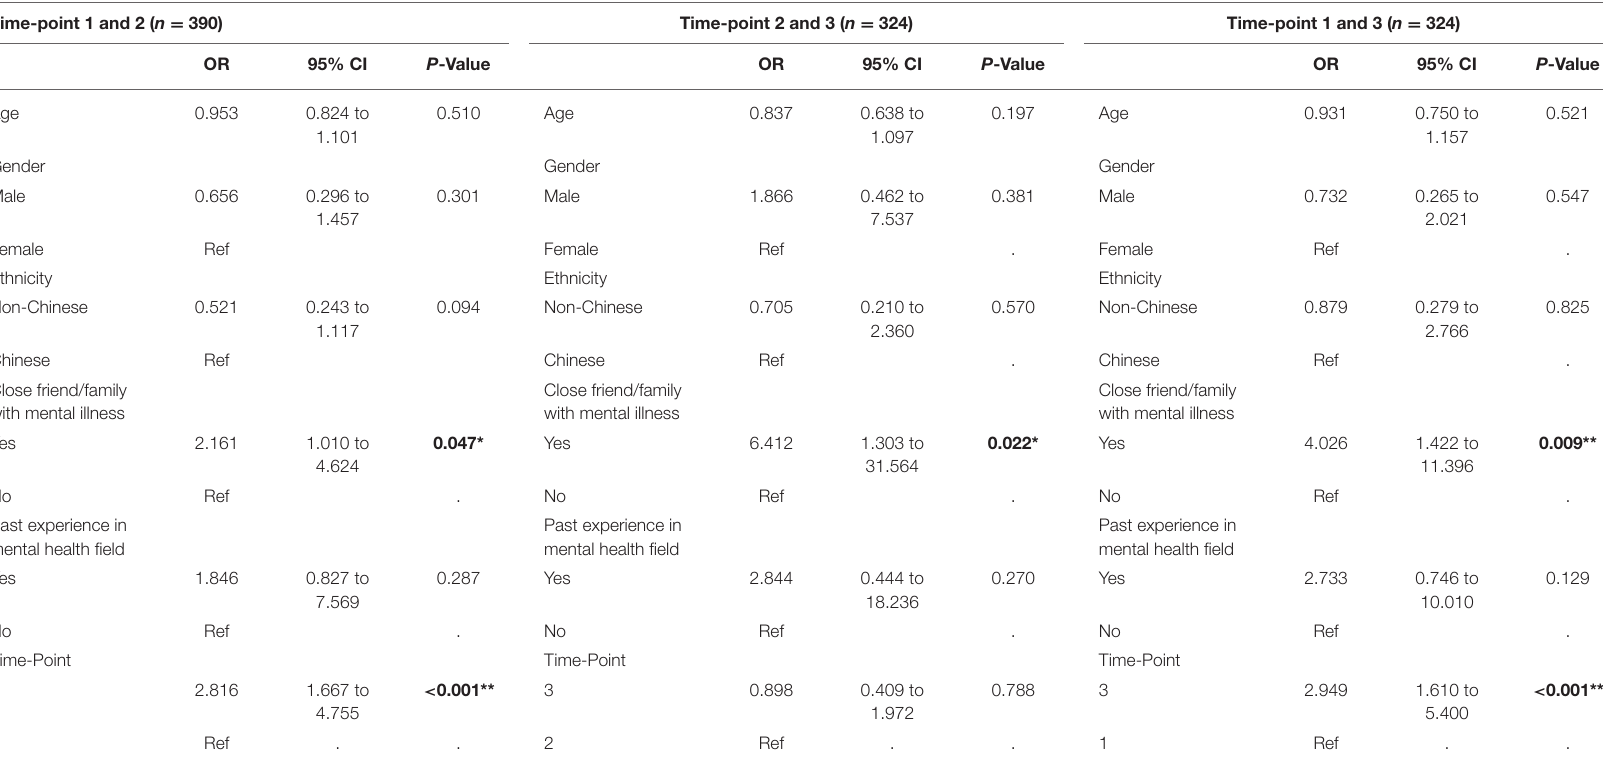
TABLE 4 | Impact of ARTEMIS on recognition after controlling for co-variates using Generalized Estimating Equation (incorrect recognition set as reference group). Time-point 1 and 2 ( n =